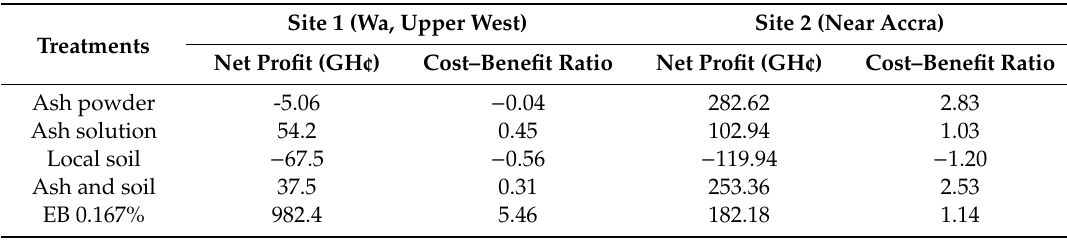
Table 3. Net profit and cost–benefit values for the e ff ects of ash- and soil-based treatments aiming to control fall armyworm in maize in Ghana compared to the negative control. Emamectin benzoate (EB) was applied as a positive